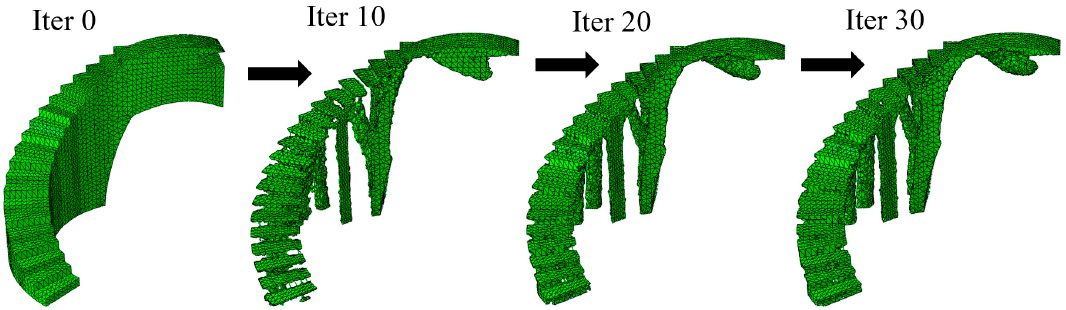
Figure 15. Evolution of the geometry of the bounding box B 1 throughout the topological optimization process.